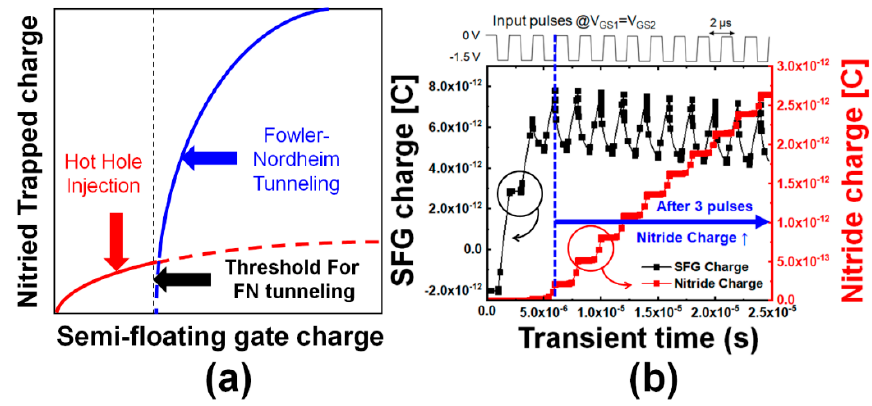
Figure 4. Total charges in the semi-floating gate (SFG) and the nitride regions. ( a ) Qualitative explanation of required holes accumulated in the SFG region to meet the condition of increased probability of injection into the nitride charge-trap layer by Fowler–Nordheim (FN) tunneling; ( b ) Total charges in the SFG (left) and nitride (right) regions after series of potentiating pulses as a function of time obtained by technology computer-aided design (TCAD) simulation.